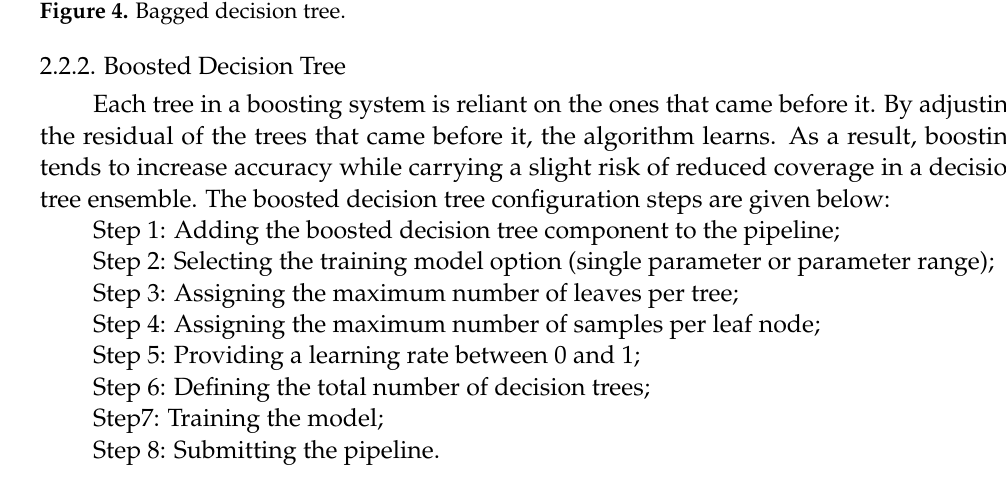
Figure 4. Bagged decision tree.